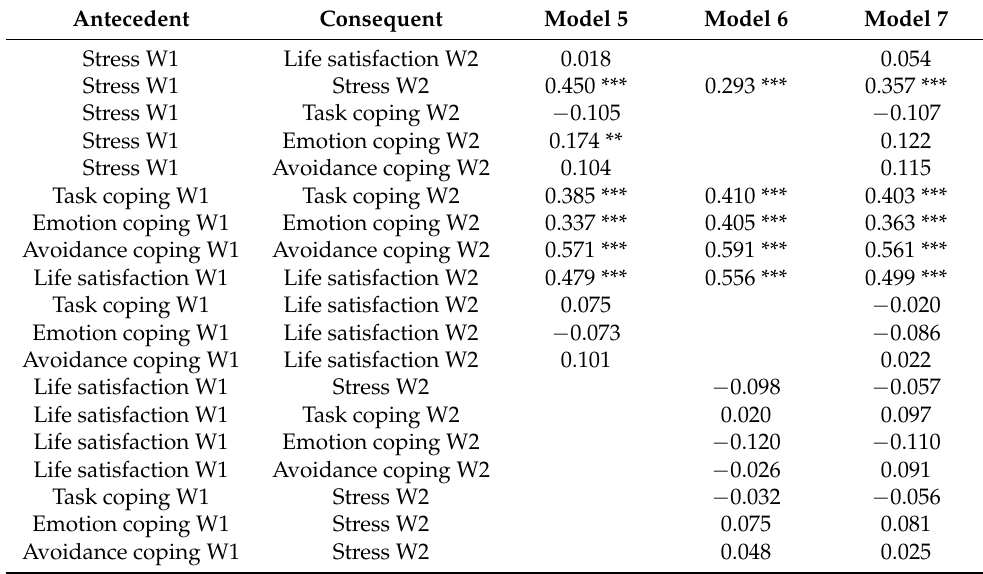
Figure 5. Conceptual cross-lagged path model for a prospective study on the parallel mediation role of coping styles in the relationship between perceived stress and satisfaction with life during the first and second waves of the COVID-19 pandemic: ( a ) perceived stress as a predictor of life satisfaction (Model 5); ( b ) life satisfaction as a predictor of perceived stress (Model 6). Table 8. Parameter estimates for latent structural mediation models in the longitudinal